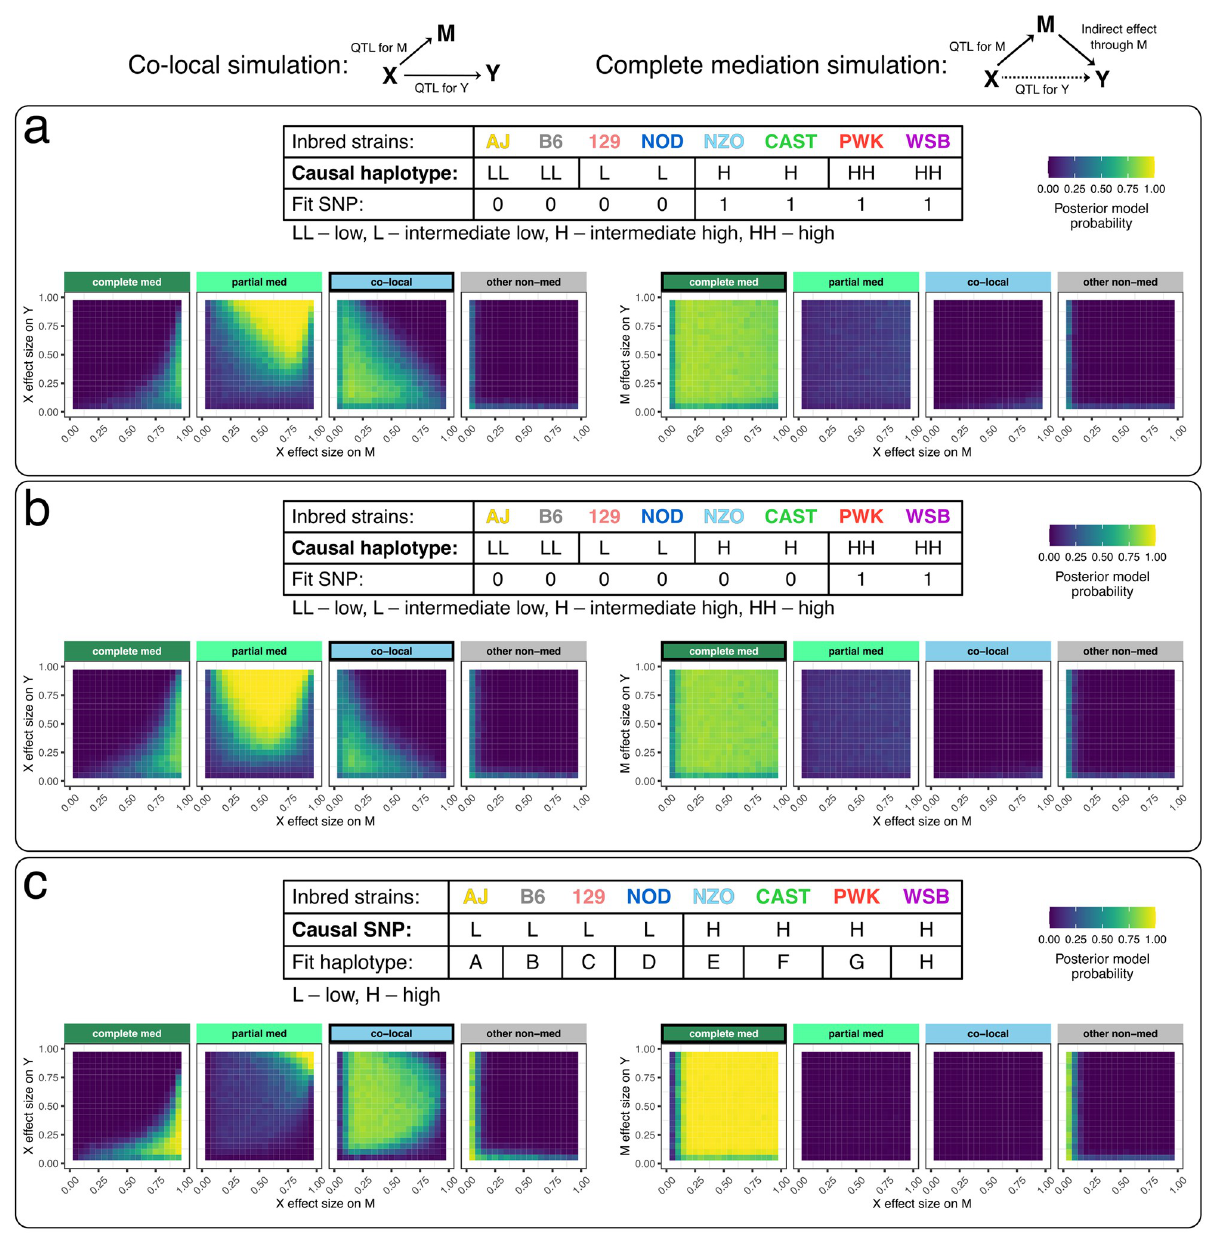
Fig 4. Performance of Bayesian model selection in simulated data with a multi-state exogenous variable. Data for 200 individuals were simulated according to co-local (left) and complete mediation (right) models. DAGs indicate the model used to simulate the data. (a-b) The genetic effect assumes four functional alleles with balanced allele frequencies (25%). Mediation analysis was performed using (a) a variant that tags the two higher functional alleles and (b) a variant that tags only the highest functional allele. (c) Data from a bi-allelic variant with allele frequency 50% were simulated, and mediation analysis performed using 8 founder haplotype states. The tables describe the structure of the genetic effect X used to simulate the data (causal) versus the X used in the mediation analysis (fit), in terms of the distribution of alleles among the founder strains. For example in (a), the low and intermediate low functional alleles are tagged by one allele of the fit SNP and the high and intermediate high functional alleles are tagged by the other allele of the fit SNP. Heat maps for Bayesian model selection represent the mean posterior probability associated with each inferred model for a range of fixed settings of the model parameters as indicated on x- and y-axes, each simulated 100 times.